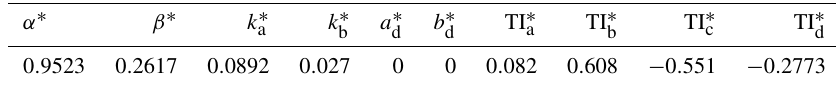
Table 1. Initial FLORIS parameters for the G1 turbine.